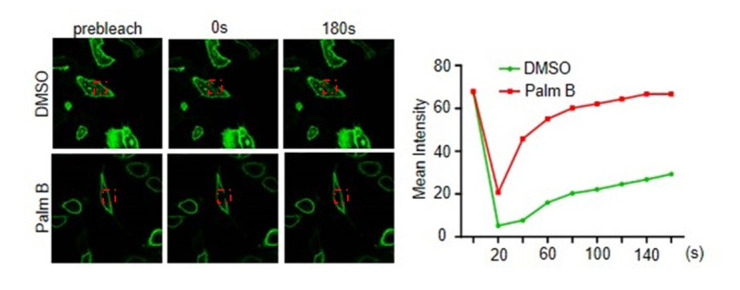
DOI:
http://dx.doi.org/10.7554/eLife.22058.017